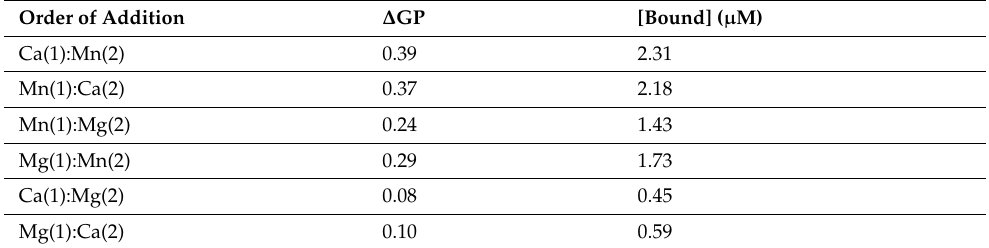
Table 6. Estimation of bound metal for sequential additions based on Figure 3.